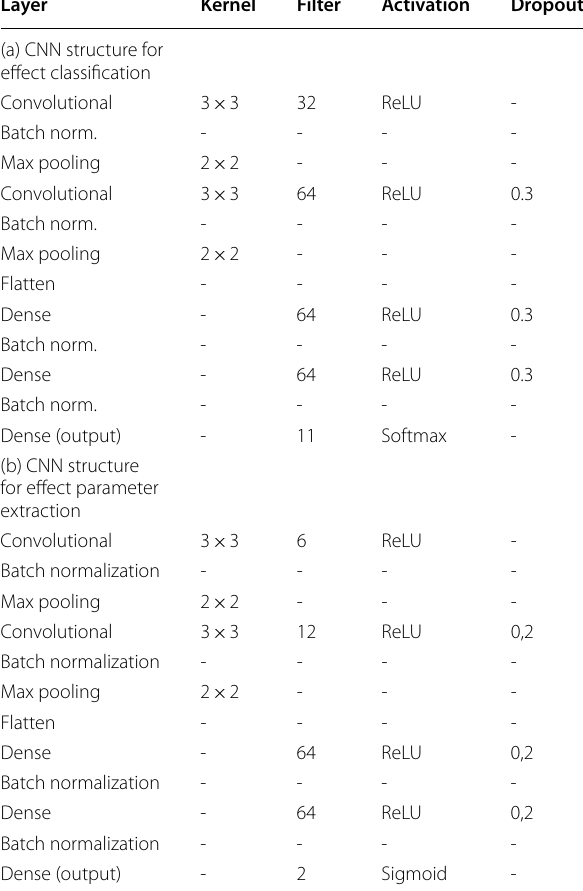
Table 2 Structure of the convolutional neural networks (CNNs) used for (a) effect classification and (b) parameter extraction. Each guitar effect investigated had two parameters resulting in an output dimension of two for the CNN for extraction of the guitar effect settings Layer